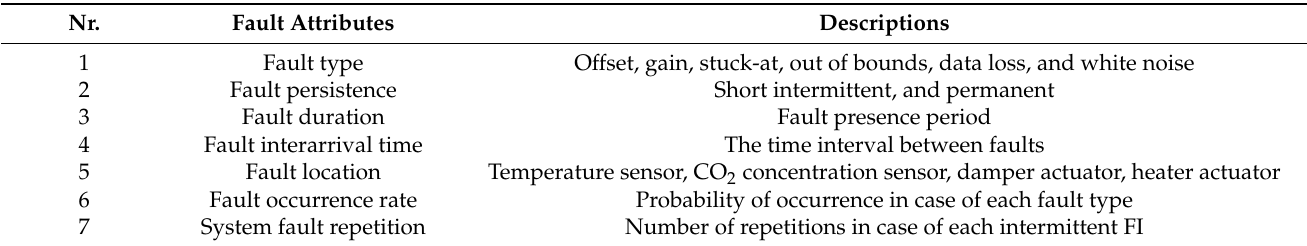
Table 3. Fault profile consisting of all required attributes for the FI